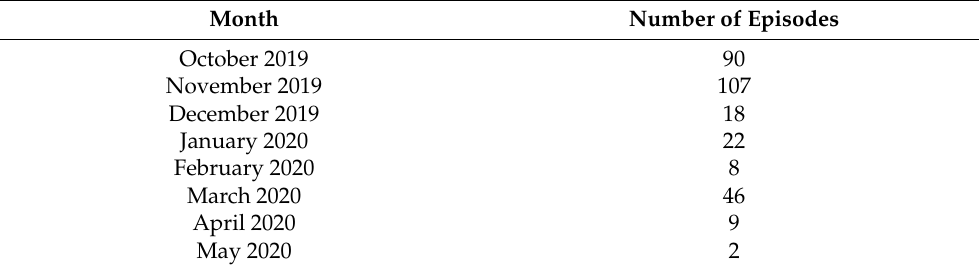
Table 6. Monthly overview of high concentration cases (PM 10 concentration exceeding an hourly average of 100 µ g/m 3 ).